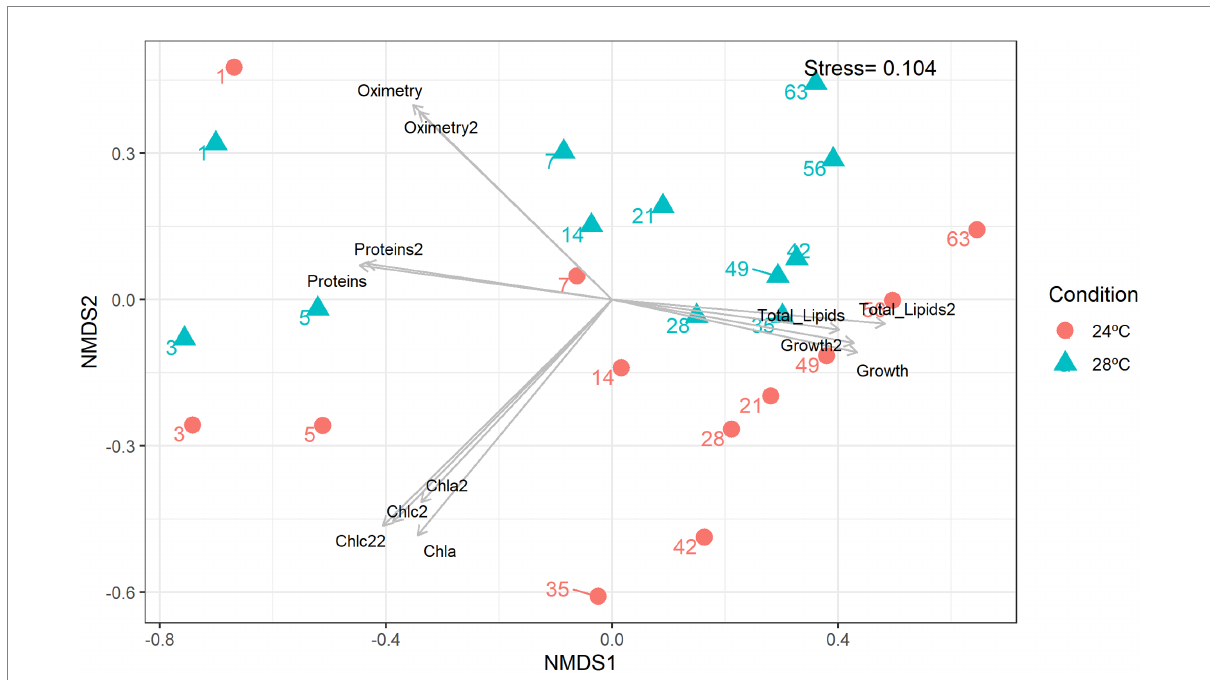
FIGURE 2 Non-metric multidimensional scaling (nMDS). Integrated cluster analysis using the cell abundance, metabolic and lipidomic profiles. nMDS plot representing the Bray–Curtis similarity of sample profiles from temperatures and days. Each dot represents a sample, the color represents the sampling temperature, and the arrows represent the nMDS abiotic characteristics